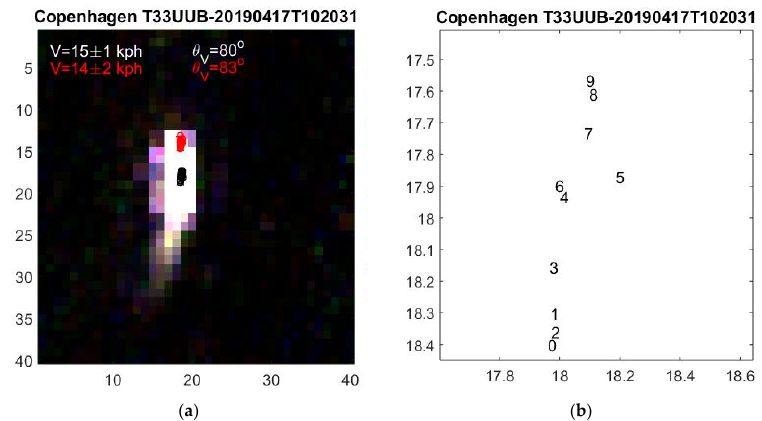
Figure 6. ( a ) Ship with short wake. As all ten multispectral ship images almost overlap, they appear white. The central positions shown with black numbers m = 0, ..., 9 are expanded in ( b ). The temporal ordering appears approximately correct.